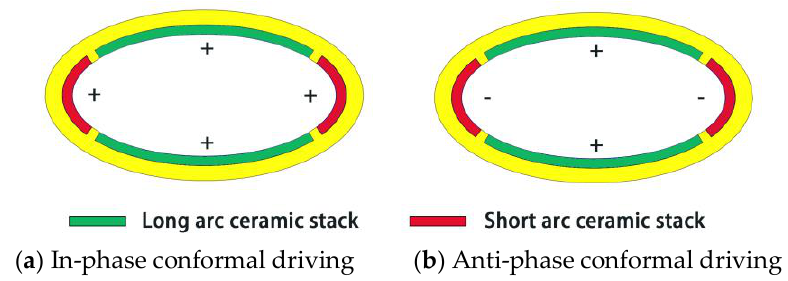
Figure 4. Two types of driving method of conformal driving Class IV FTs.